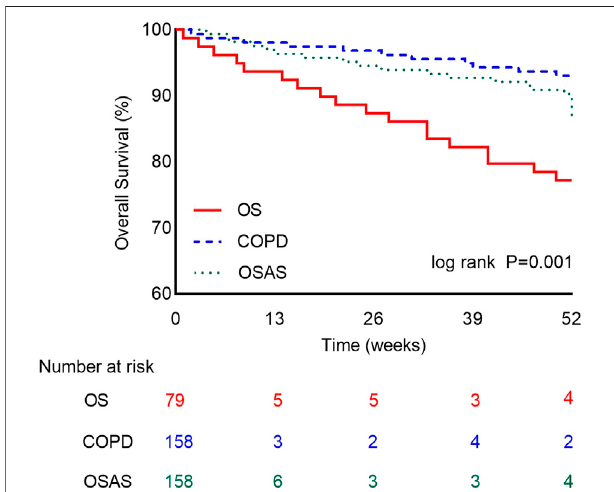
FIGURE 2 | The One-Year Kaplan-Meier Survival Curves. Survival rate betweenpatientsintheOSgroup(redline),COPDgroup(blueline),andOSAS group (green line). The difference is statistically signi fi cant. (Log-rank test (cid:1) 14.128, p (cid:1)